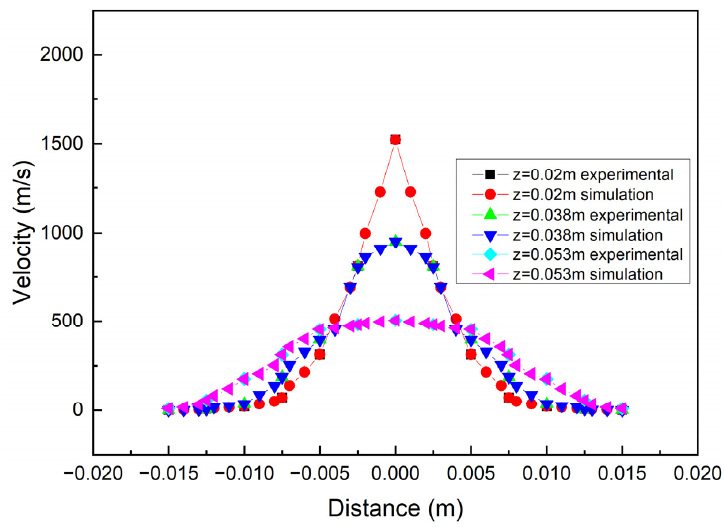
Figure 5. Accuracy